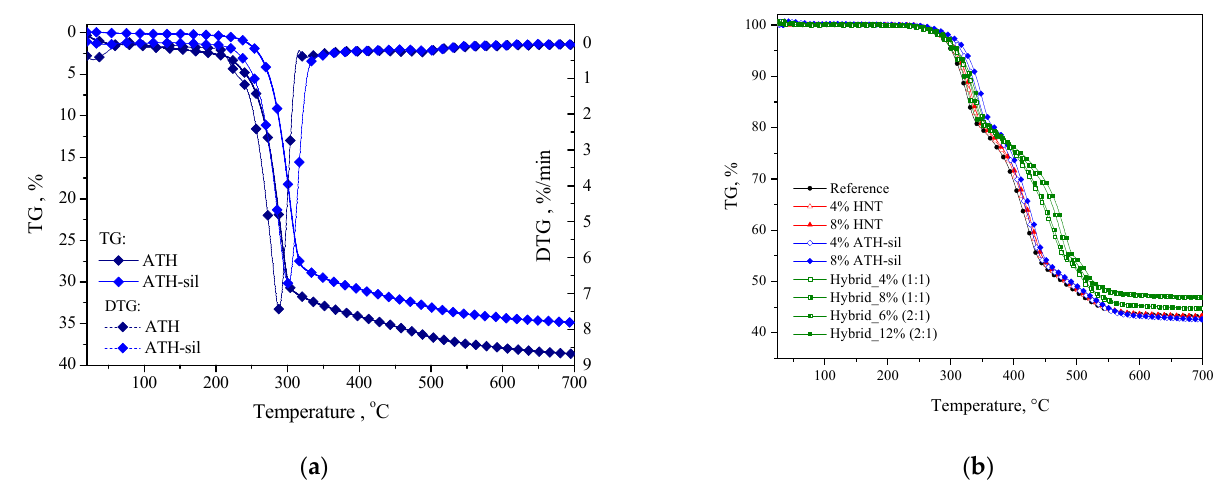
Figure 7. Thermal degradation behavior evaluated in the oxidizing atmosphere for ( a ) ATH and ATH-sil and ( b ) prepared materials.